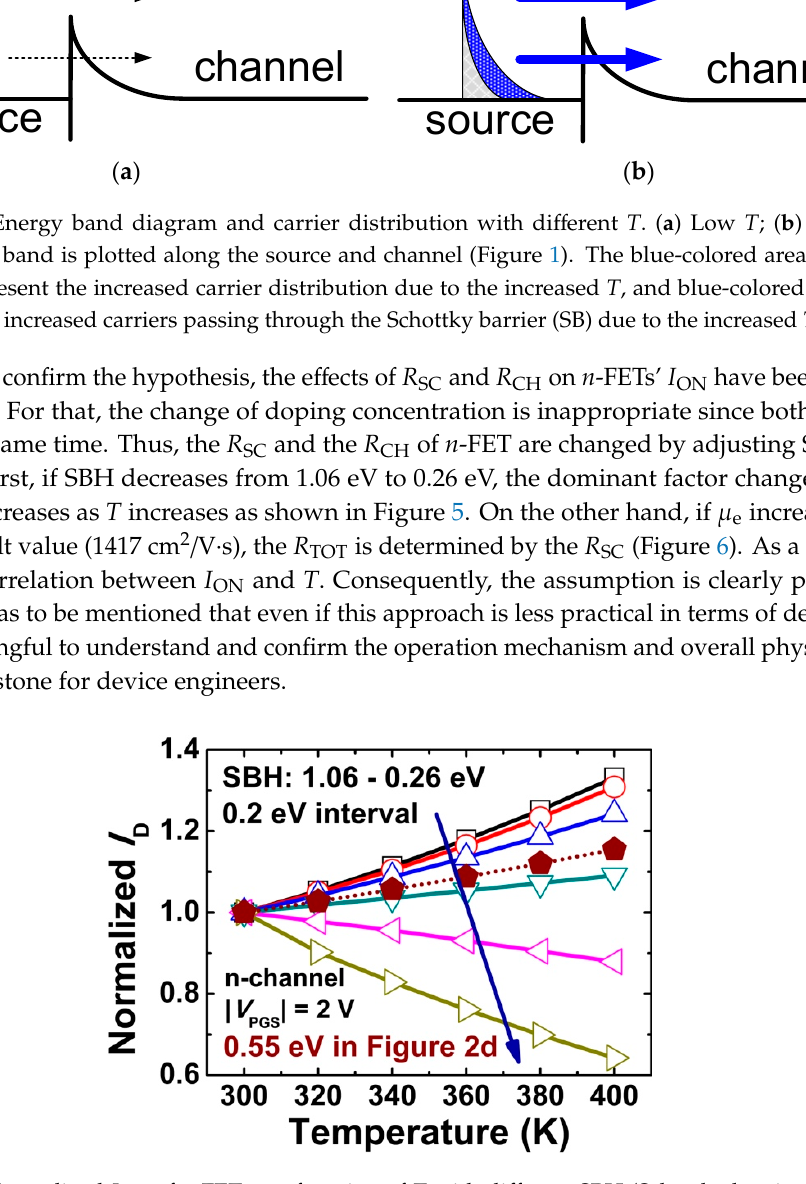
Figure 5. Normalized I ON of n -FET as a function of T with different SBH (Schottky barrier height) . The blue arrow shows a decrease in the normalized I D due to SBH reduction.